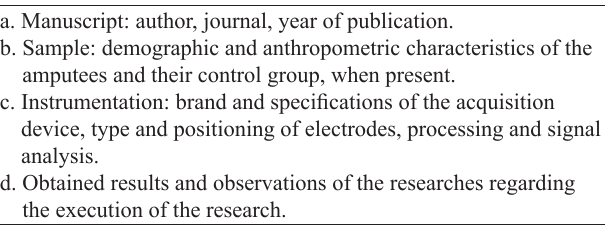
Table 2. Aspects of interest evaluated in studies